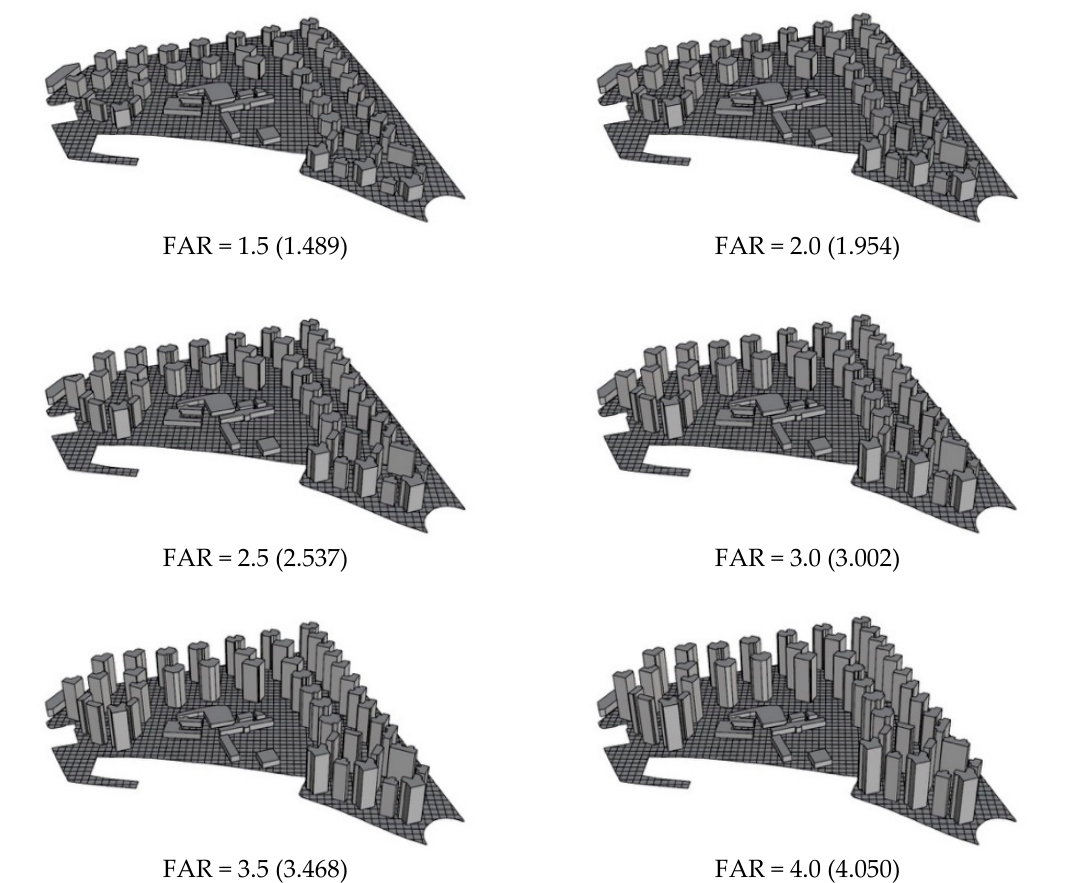
Figure 3. Models for study site E with six density levels for solar environment analysis using DIVA-for-Rhino.